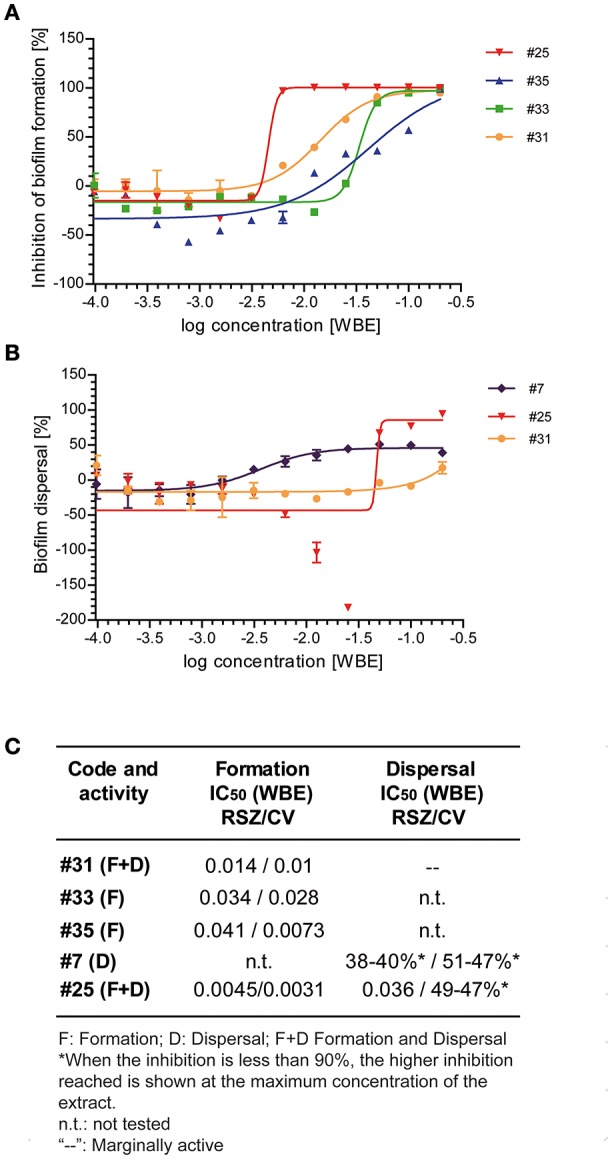
Dose-response curves of the selected extracts identified for its activity inhibiting biofilm formation (#25, #35, #33, and #31) or its activity dispersing preformed biofilms (#7, #25, and #31). Dose-response curves of the indicated extracts on biofilm formation assays (A) or on biofilm dispersal assays (B). The inhibitory activity of each extract was determined by RSZ staining. Mean and standard error of mean of two independent experiments is shown. (C) IC50-values obtained after staining with RSZ and CV are shown in whole broth equivalents of the selected natural extracts.